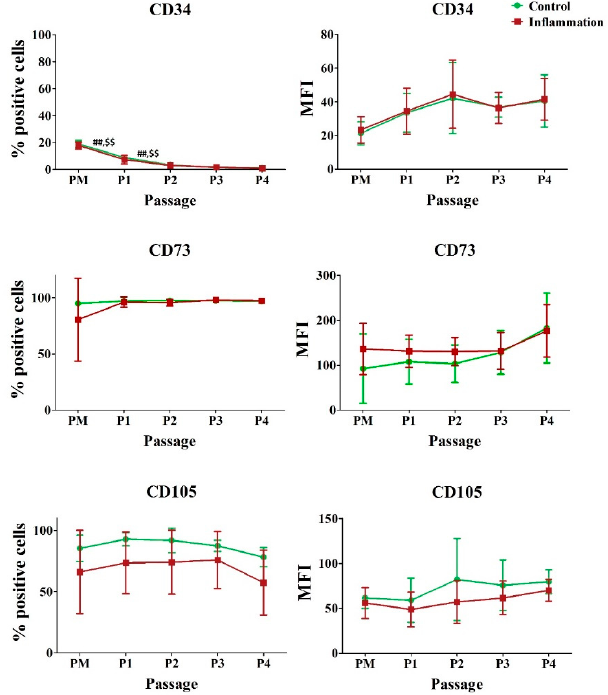
Figure 1. Impact of inflammation and cell passaging on the expression of endothelial/stromal markers in AT-MSCs. Flow cytometric analysis was used to determine the percentage of positive cells and the protein expression per cell (MFI). The values are expressed as mean ± SD and originate from six di ff erent AT-MSC donors. ## Significantly lower percentage or amount per cell in non-stimulated AT-MSCs compared to the consecutive passage ( p -value < 0.05). $$ Significantly lower percentage or amount per cell in inflammation-stimulated AT-MSCs compared to the consecutive passage ( p -value <